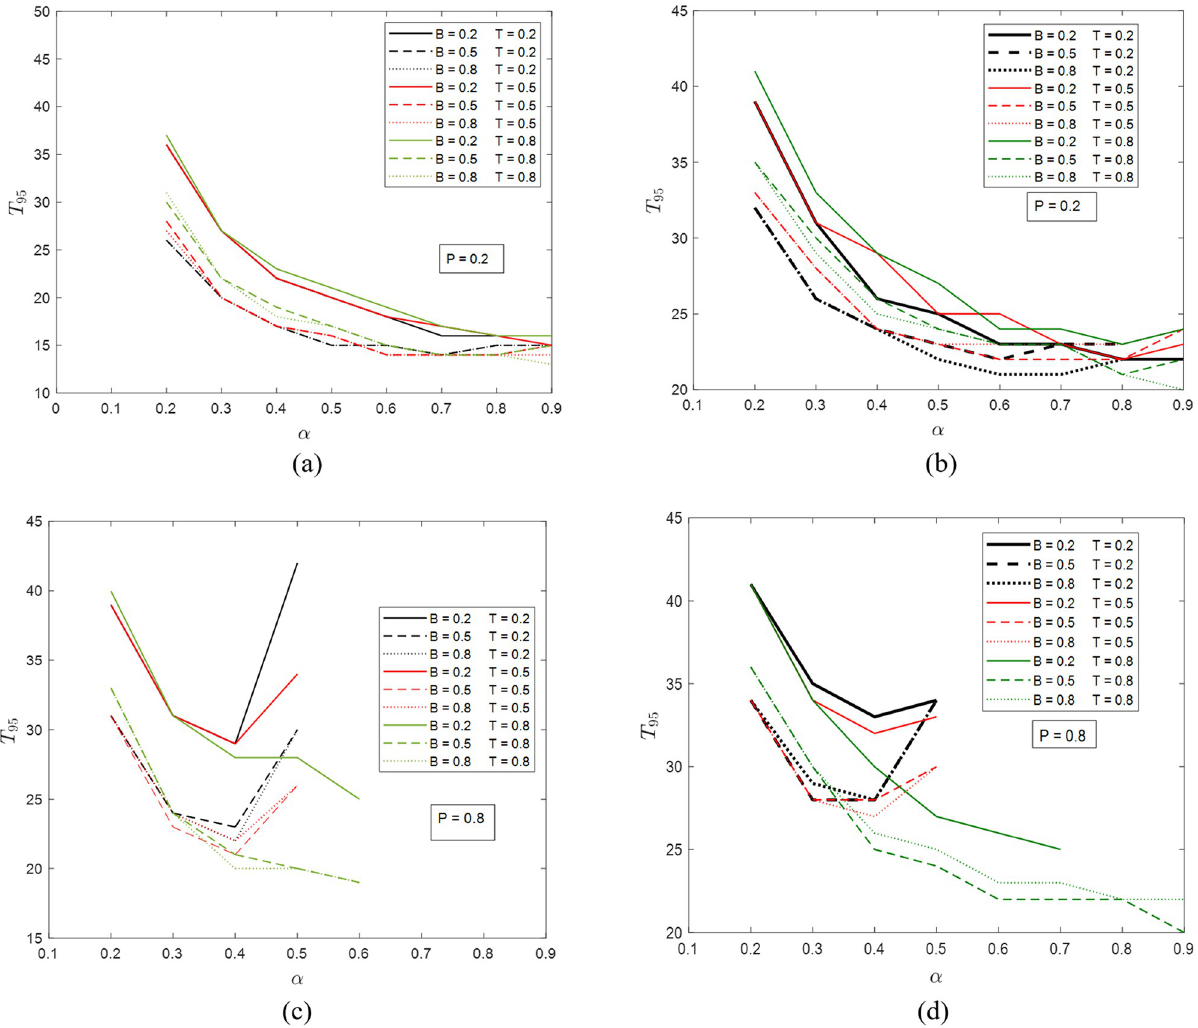
Fig 7. The time needed for 95% recovery in (a) the ER network with P = 0.2, (b) the SF network with P = 0.2, (c) the ER network with P = 0.8, and (d) the SF network with P = 0.8. The possible values of B and T are 0.2, 0.5, and 0.8. The values of α are from 0.2 to 0.9 at step size 0.1. In some cases with higher α , the system can never reach 95% recovery and therefore no data points are shown in the